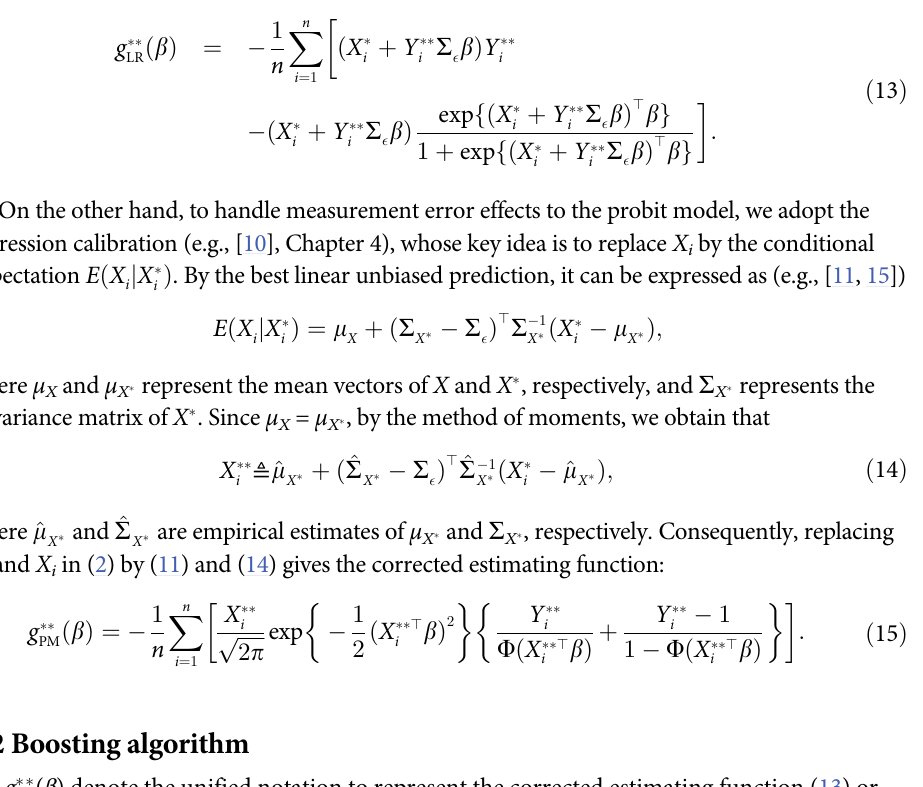
Algorithm 1: Boosting Procedure in